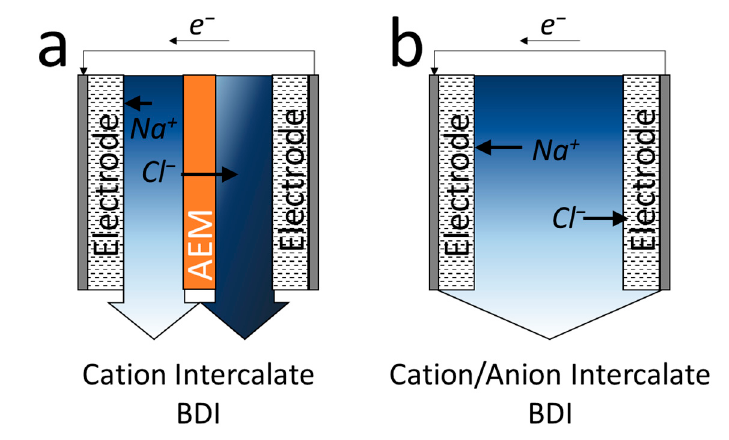
Figure3. Schematicandworkingprincipleof( a )cationintercalatebatterydeionization(BDI)(symmetric) Figure 3. Schematic and working principle of ( a ) cation intercalate battery deionization (BDI) and ( b ) cation / anion (asymmetric) intercalate BDI (symmetric) and ( b ) cation/anion (asymmetric) intercalate BDI processes.